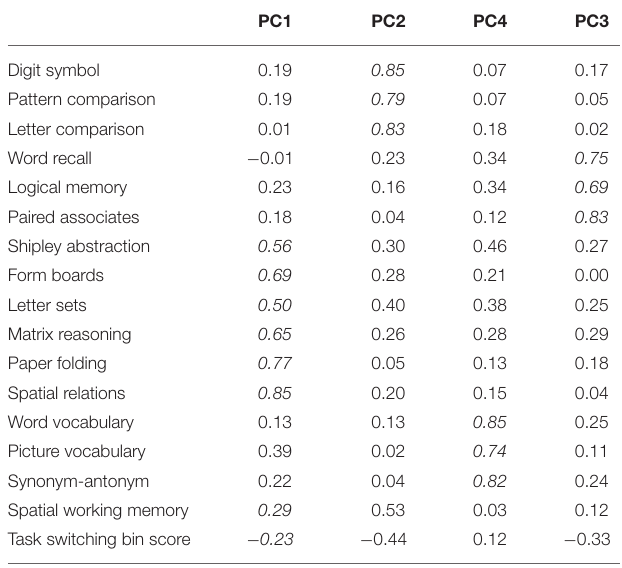
TABLE 2 | PCA standardized loadings (pattern matrix) based upon correlation matrix of baseline